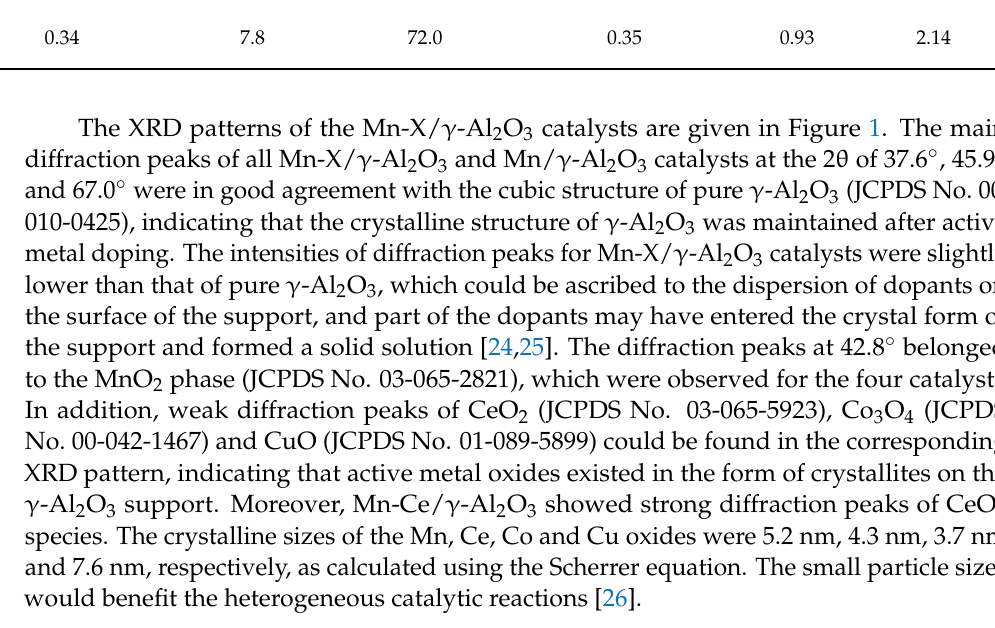
Table 1. Physicochemical properties of the Mn-X/ γ -Al 2 O 3 catalysts .